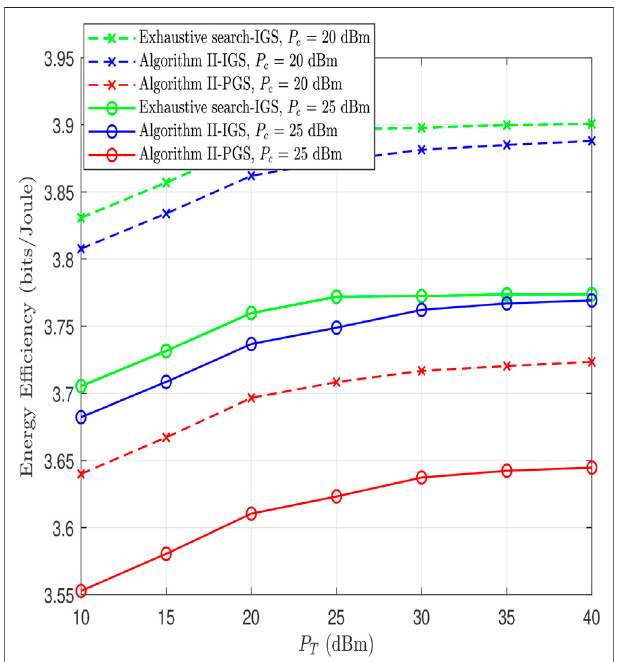
FIGURE 9 | BER with improper constellation 16-QAM at η =